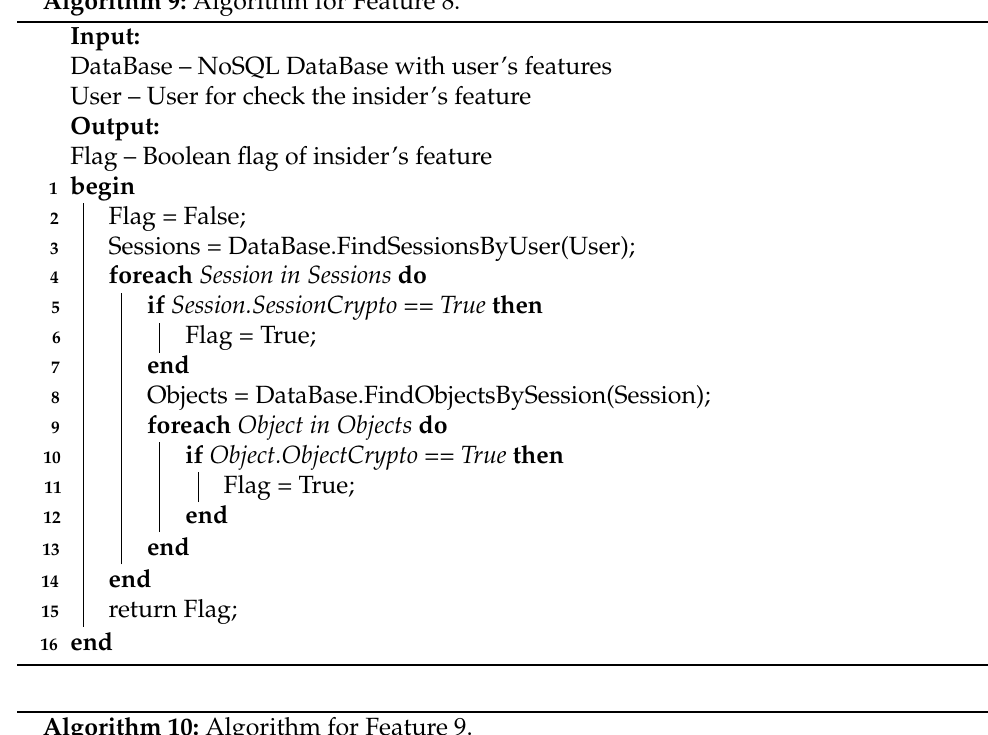
Algorithm 10: Algorithm for Feature 9.